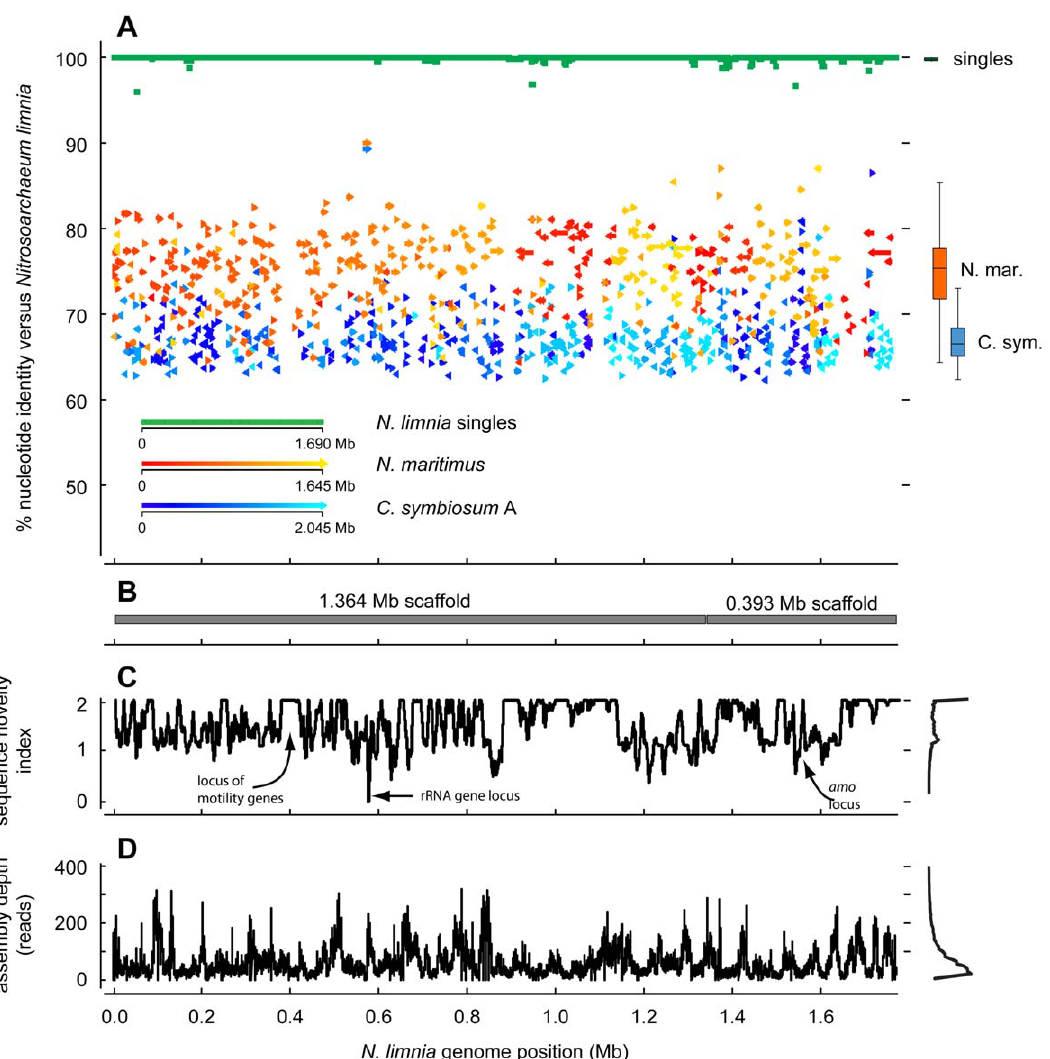
Figure 4. Comparison of three AOA genomes. (A) The top panel shows nucleotide identity of blast hits between the reference genomes and the N. limnia genome. Hits for N. maritimus and C. symbiosum A are colored according to the position in the reference (query) genome. The arrow direction indicates the hit direction. On the right, box plots summarize the distribution of hits from each reference genome to the N. limnia genome. (B) The positions of the two largest consensus scaffolds are shown. (C) The sequence novelty index, defined as 2 minus the sum of nucleotide identity of blast hits to N. maritimus and C. symbiosum A at each position is plotted. A histogram of the values is present at right. (D) The alignment depth in the final assembly is shown. A histogram of the values is present at